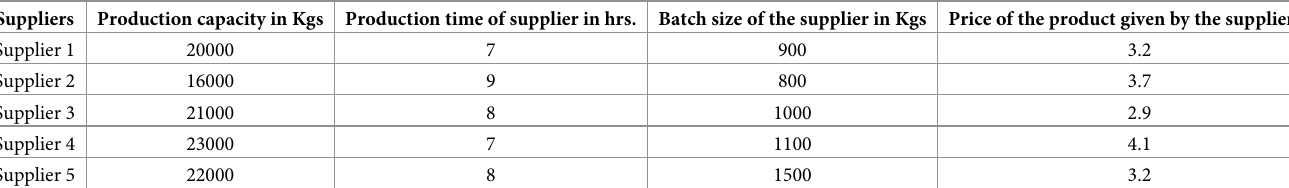
Table 7. Capacity, production time, batch size, and price of the product of each supplier.